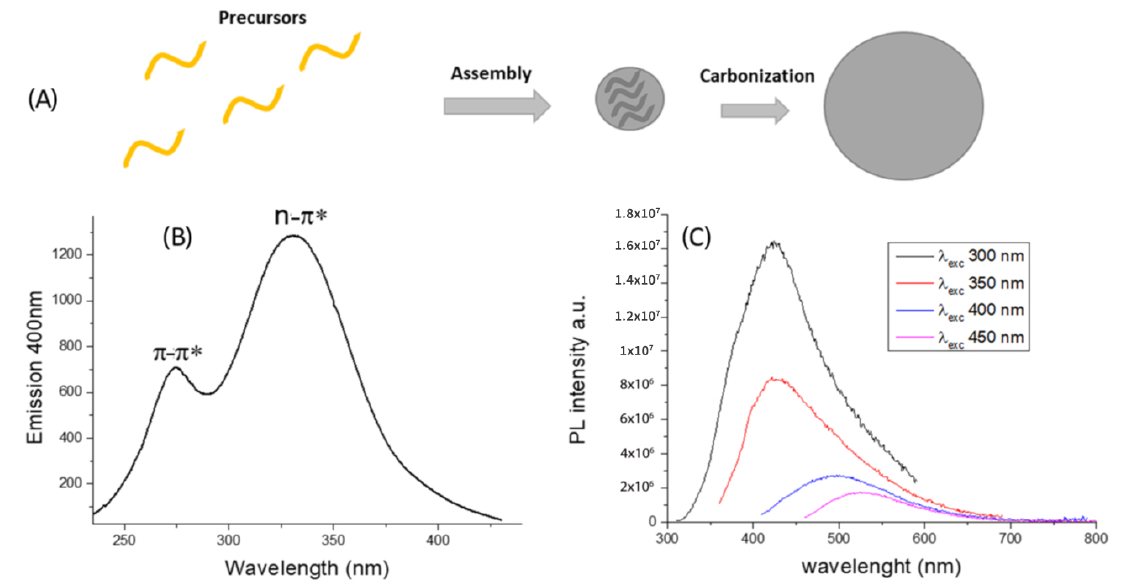
Figure 1. ( A ) Schematic representation of bottom-up CDs formation from molecules precursors and doping agent. ( B ) Exci- tation spectrum of CDs in water and ( C ) Representation of CDs wavelength-dependent photoluminescence